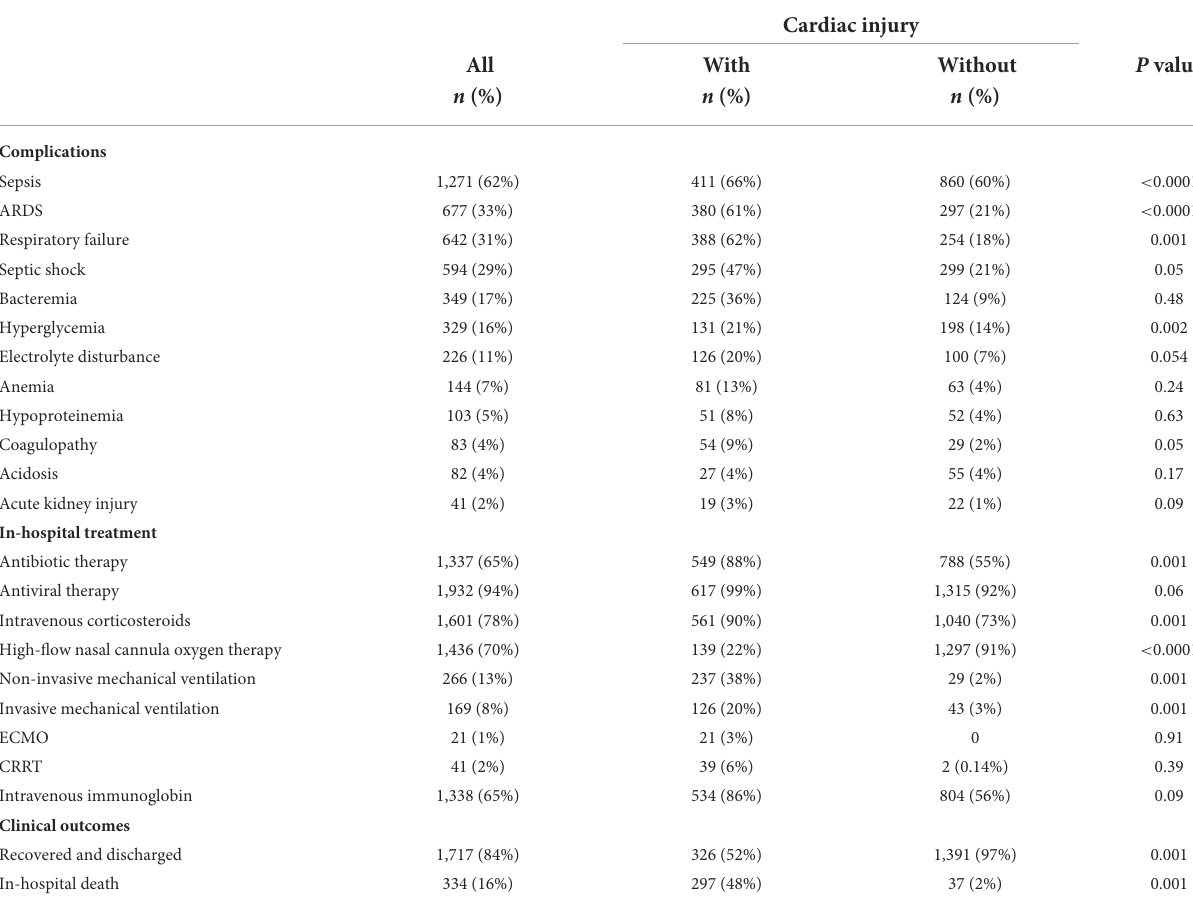
Patients No. (%) Cardiac